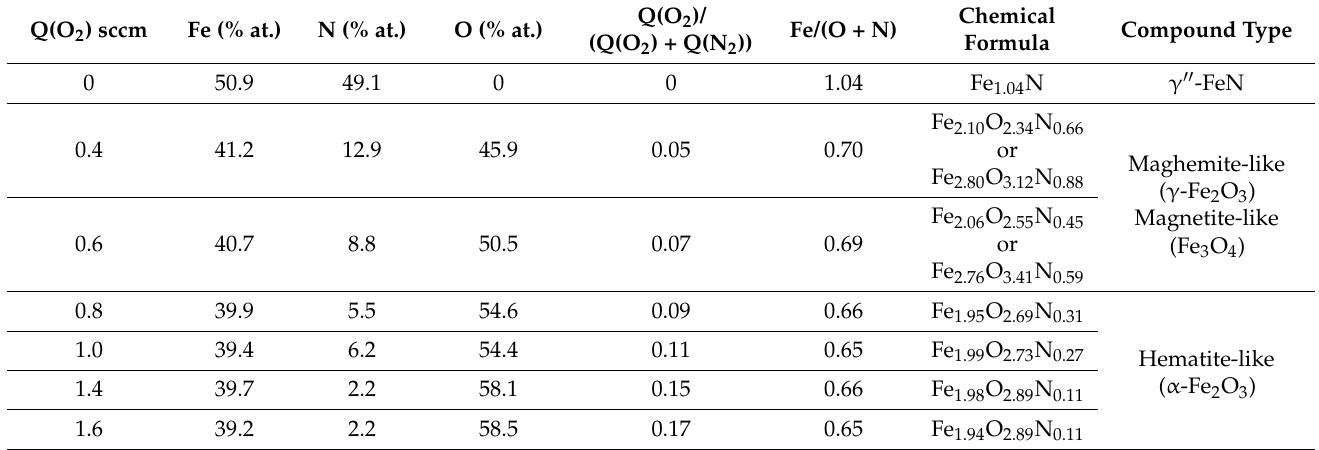
Table 1. Chemical composition, Fe/(O + N) and chemical formula determined by RBS measurements of the films deposited with Q(N 2 ) = 8 sccm and varying Q(O 2 ) from 0 to 1.6